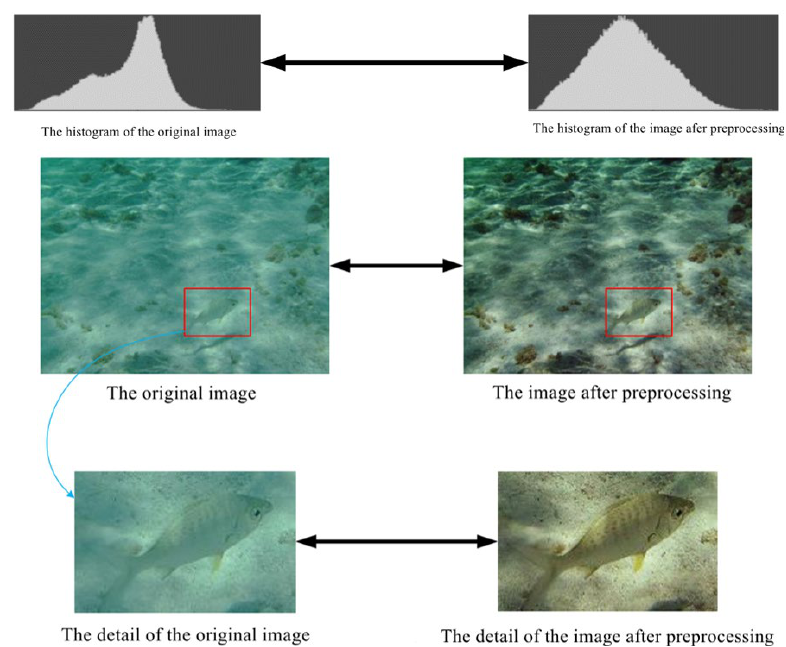
Figure 2. The original image before and after image preprocessing and histogram comparison. The first row shows that the histogram distribution becomes more uniform, indicating that the enhanced image has a better color gamut value. The last two rows show a higher degree of discrimination, improving the feature extraction performance of the detection model.